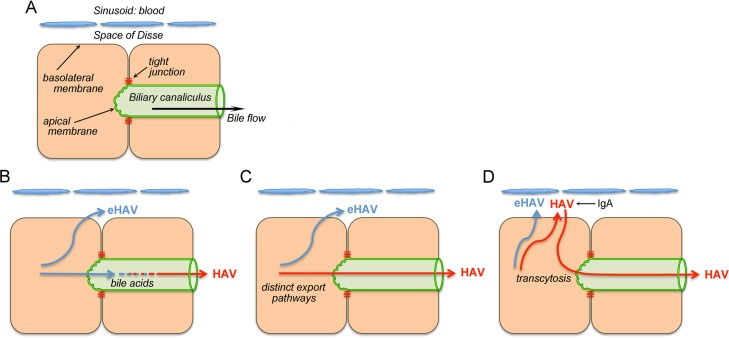
Microanatomy of the hepatocyte and three possible explanations for the presence of different forms of HAV in blood (quasi-enveloped) and feces (naked, nonenveloped). (A) Simplified diagram showing two hepatocytes in relation to the space of Disse and hepatic sinusoid that is bathed in blood and to the biliary canaliculus that encircles hepatocytes in a belt-like fashion and into which virus and bile are secreted across the hepatocyte apical membrane. Bile flows from the canaliculus to larger bile ductules and ultimately to the lumen of the gastrointestinal tract. (B to D) Competing hypotheses that could explain differences in membrane association and quasi-envelopment of virus in different compartments. See introductory text for details.